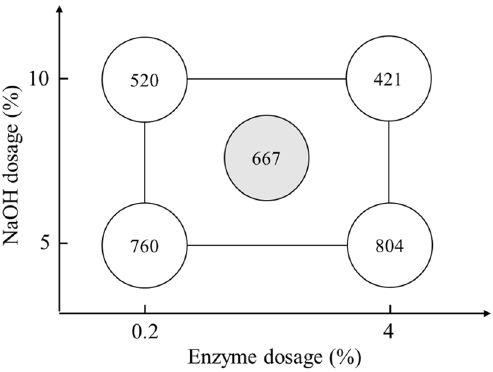
Figure 4. Factorial analysis of rice straw semi-chemical mechanical pulp freeness (CSF, mL) before refining.